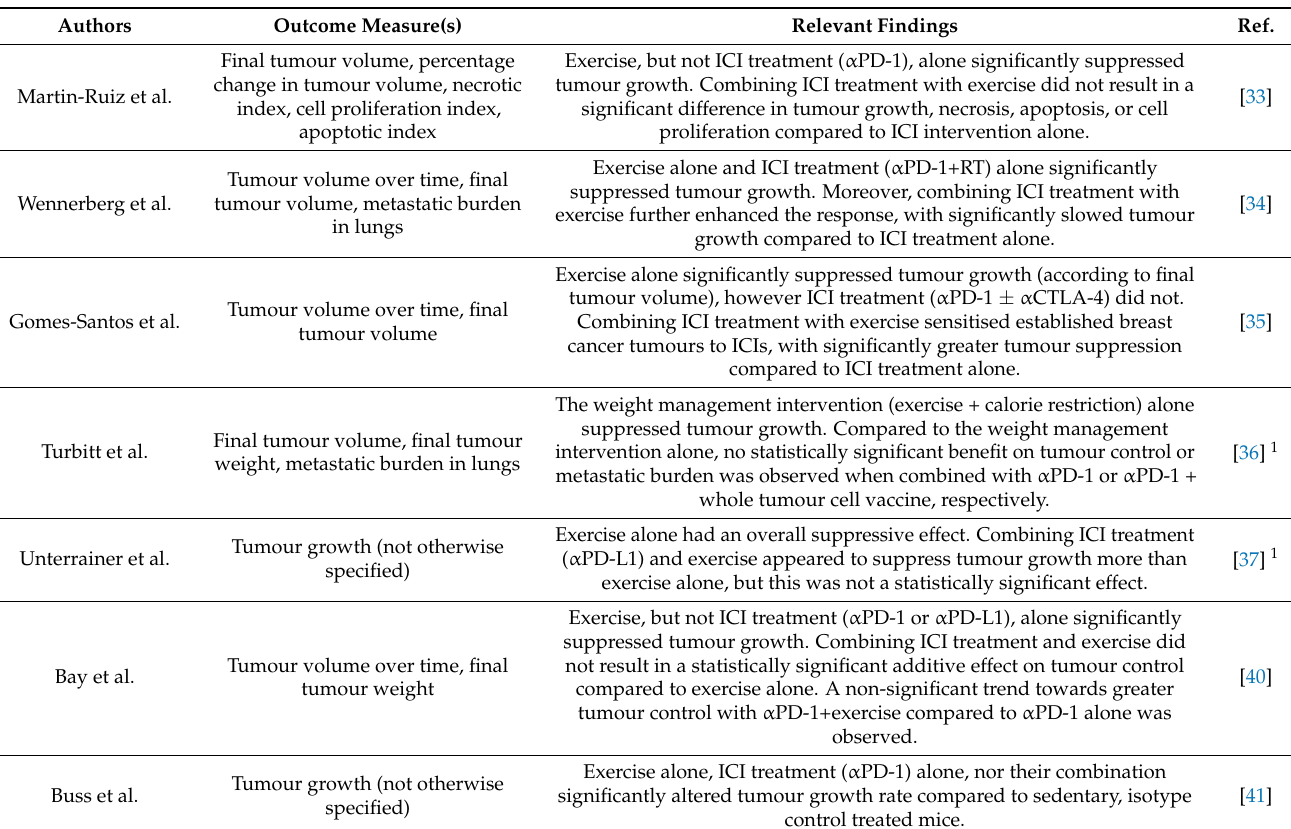
Table 3. Findings from studies addressing the effect of exercise on oncological responses to ICIs (n =